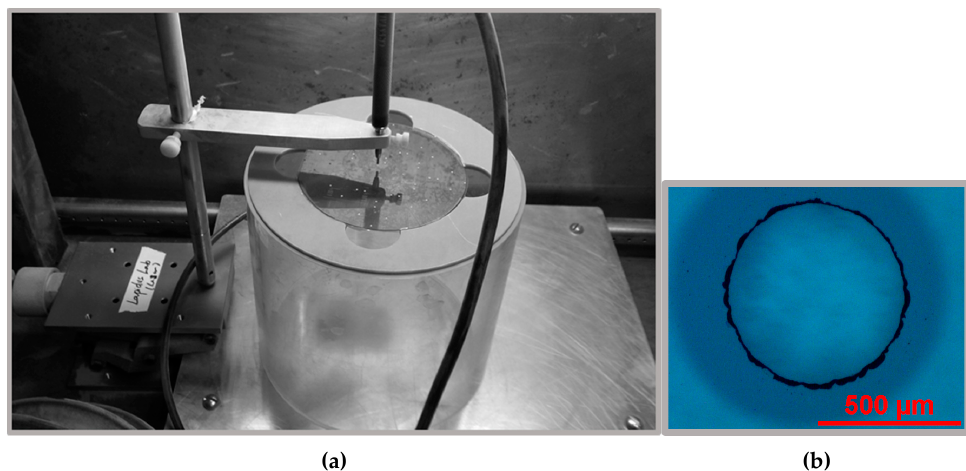
Figure 5. ( a ) Sandblaster set-up; and ( b ) microscope picture of the inlet hole made from the sandblaster.